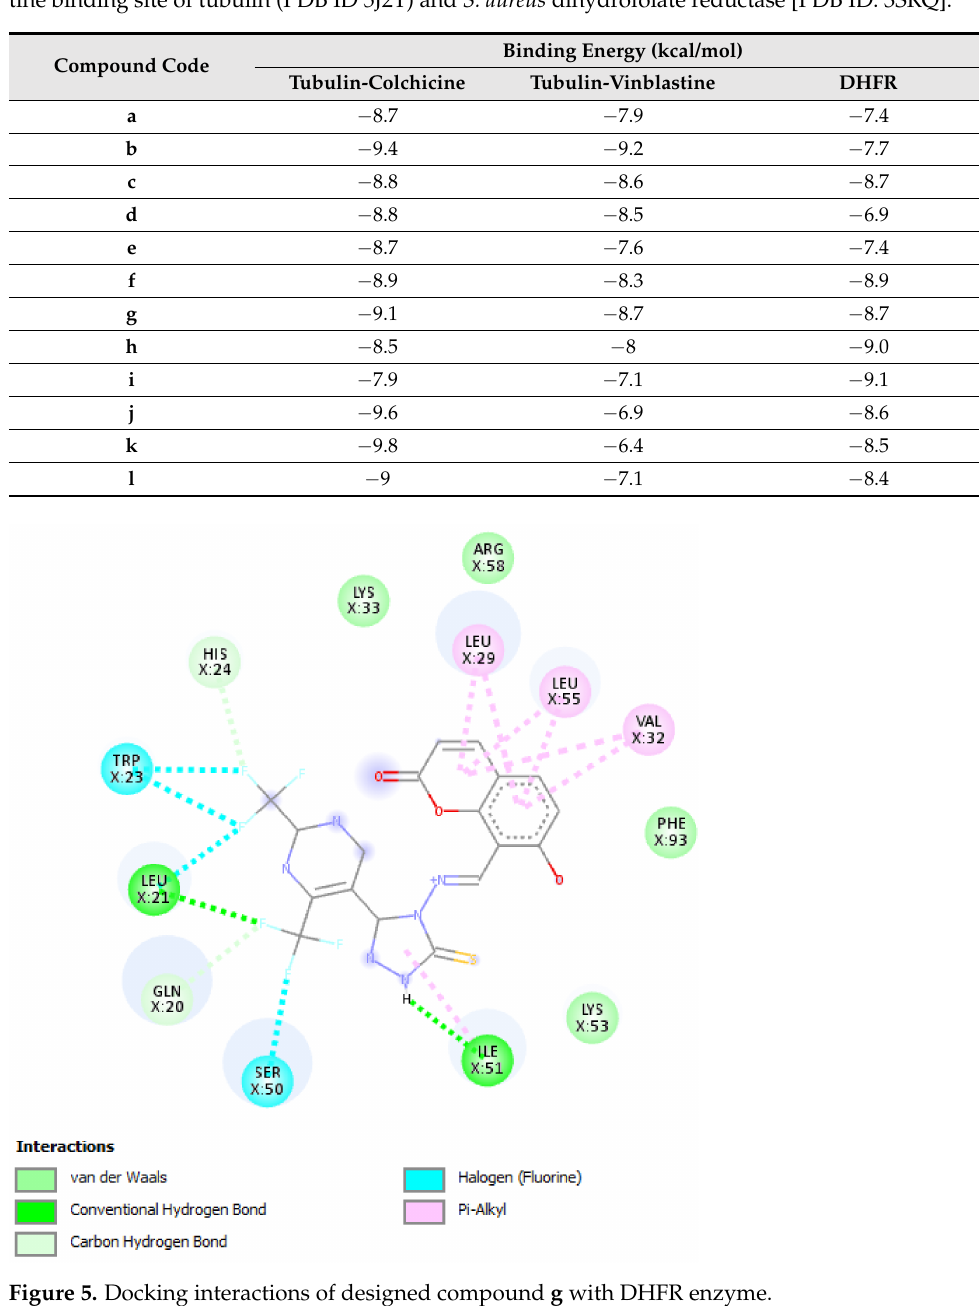
Table 6. Binding energies of compounds targeting colchicine binding site (PDB ID 1SA0) and vinblas- tine binding site of tubulin (PDB ID 5J2T) and S. aureus dihydrofolate reductase [PDB ID: 3SRQ].